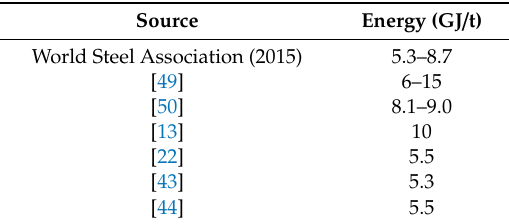
Table 10. Energy for steel recycling with electric arc furnace.